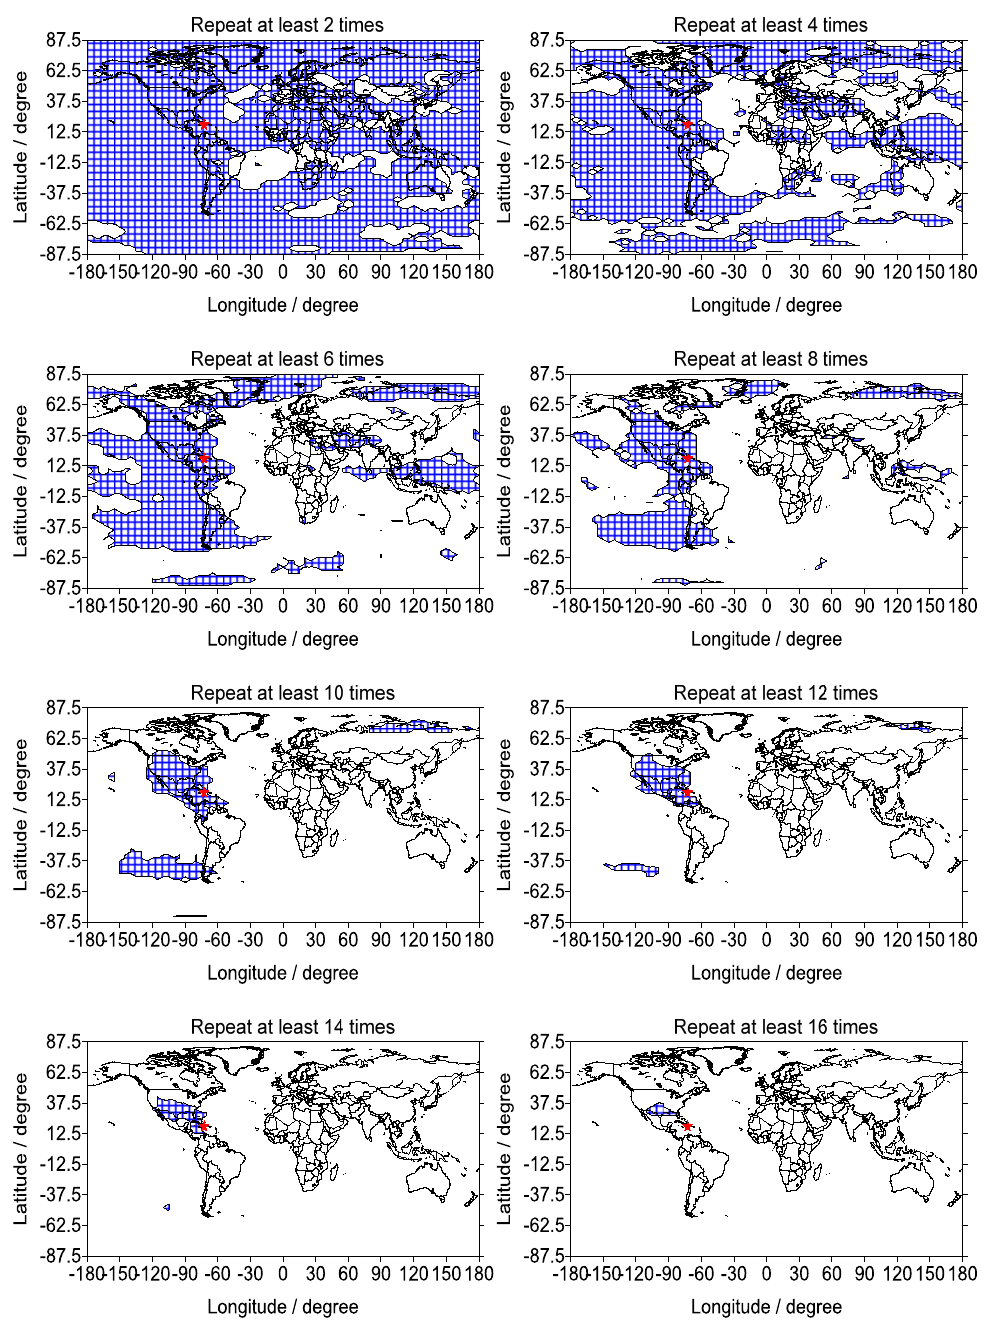
Fig. 4. Locations of the 30-day extreme enhancement that repeatedly appeared at various time points on 11–12 January 2010. The number of repeat time points is noted on top of each panel. The red star symbol denotes the epicenter.